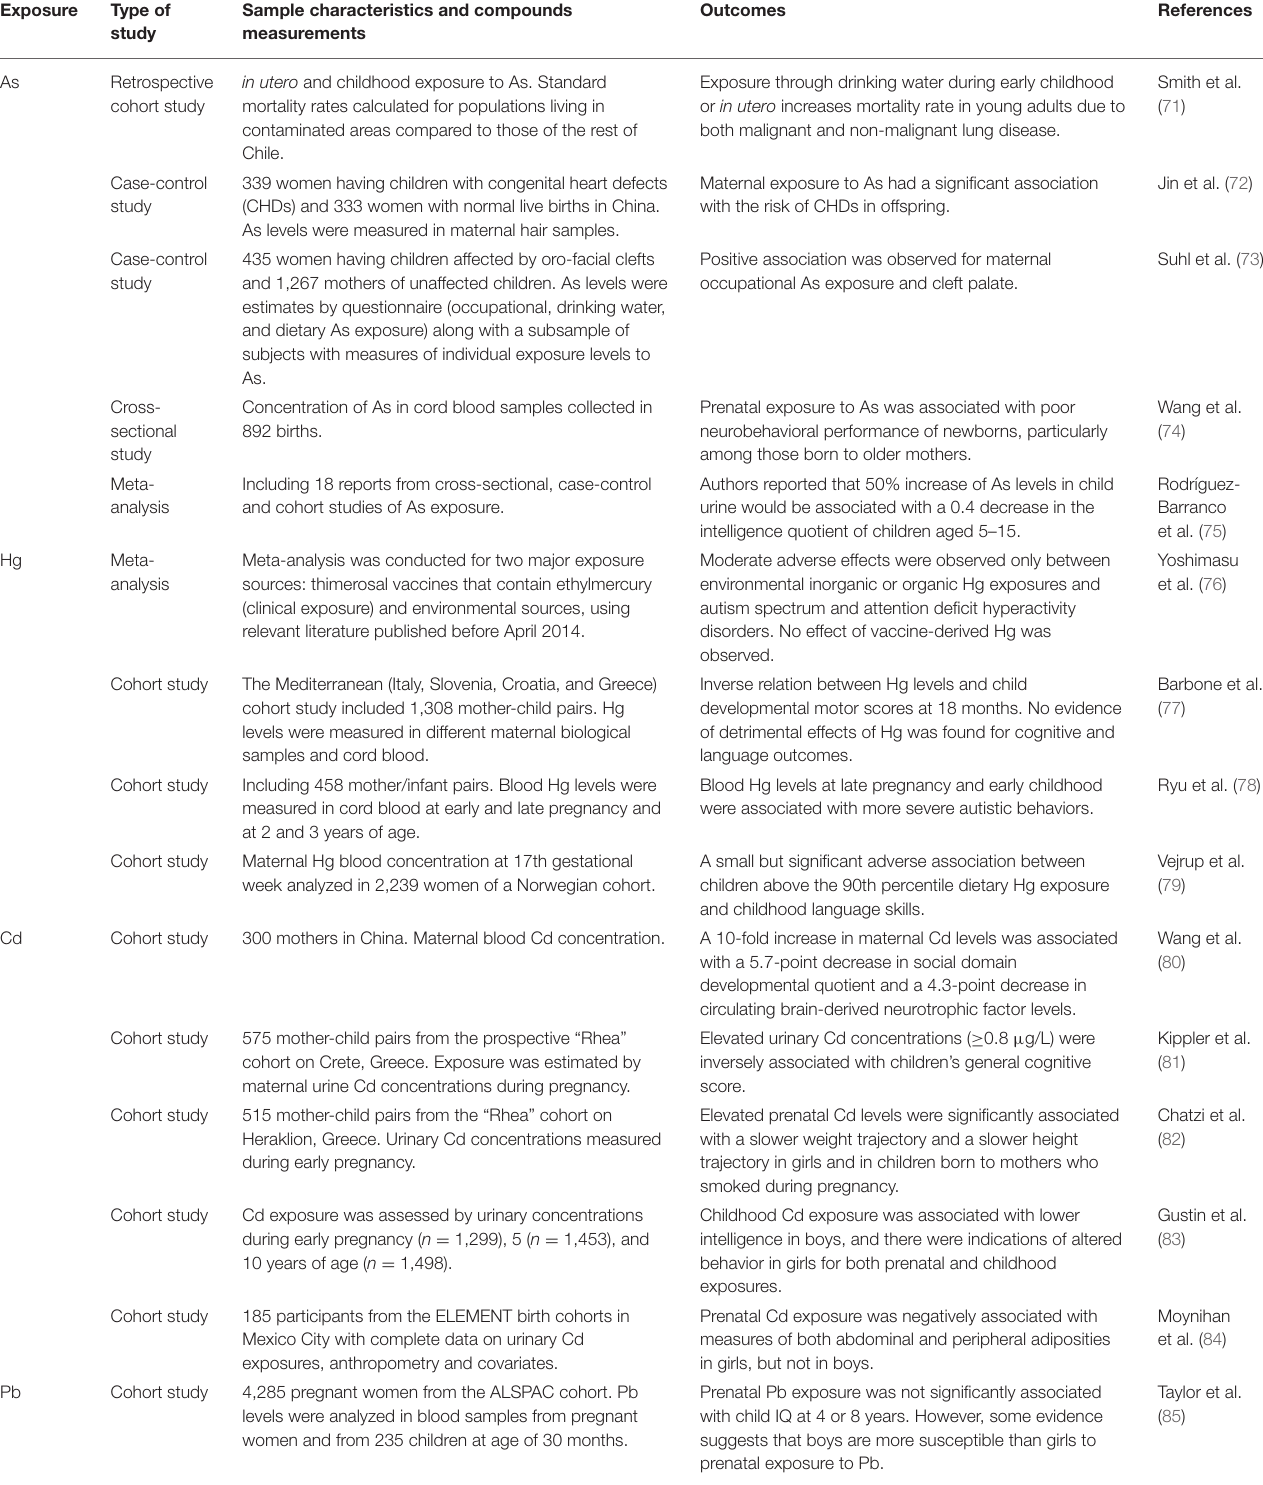
TABLE 1 | Selected list of studies on environmental pollutants performed in pediatric age in highly polluted areas, along with the relevant health outcomes.